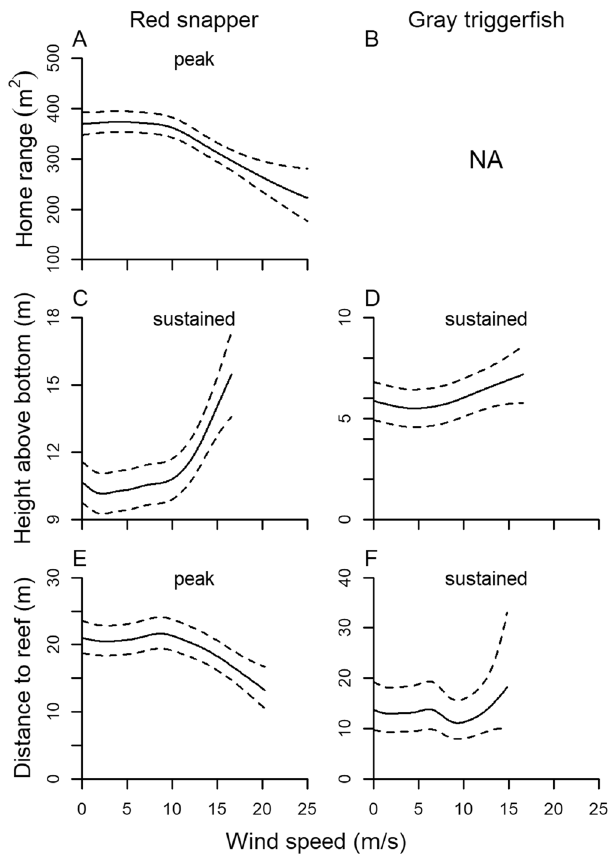
Figure 8. GAMM predicted (solid line) and 95% CIs (broken line) of hourly home range (95% KDE; A , B ), height above bottom ( C , D ), and distance to reef ( E , F ) of red snapper and gray triggerfish as a function of sustained or peak wind speed.